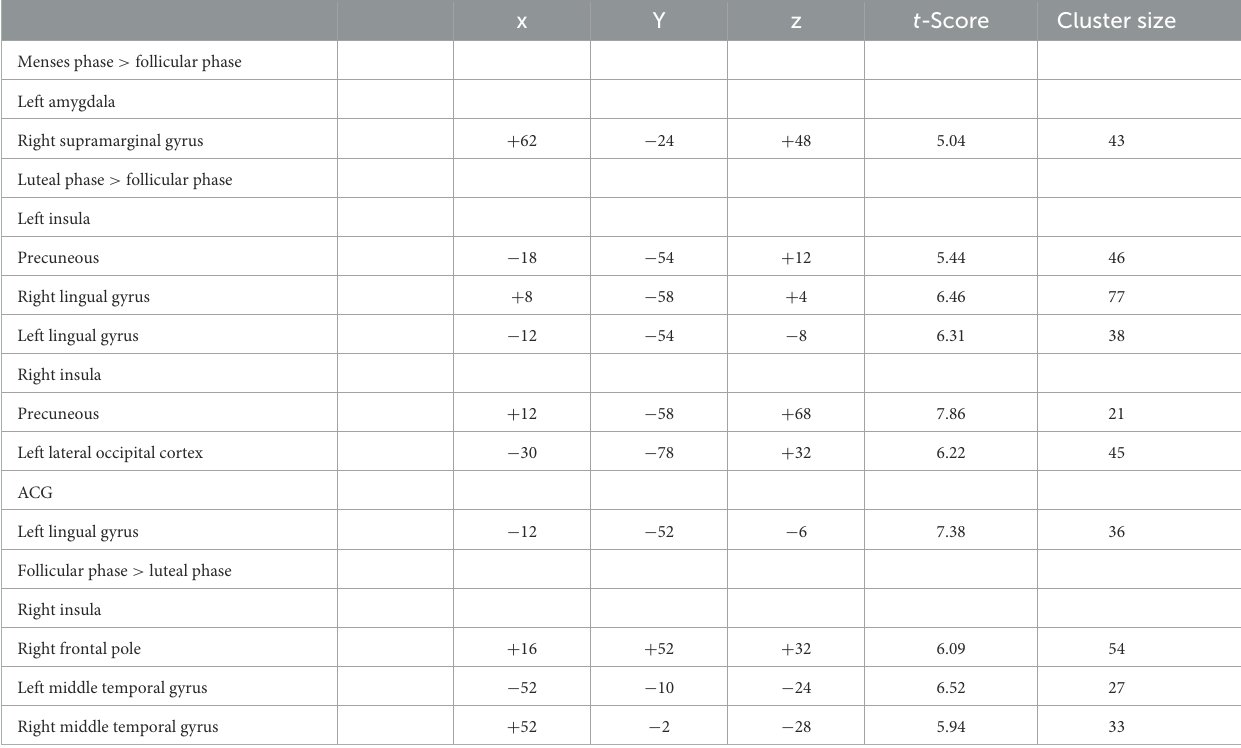
TABLE 2 Differences in amygdala, ACG, and insula resting-state functional connectivity for naturally cycling